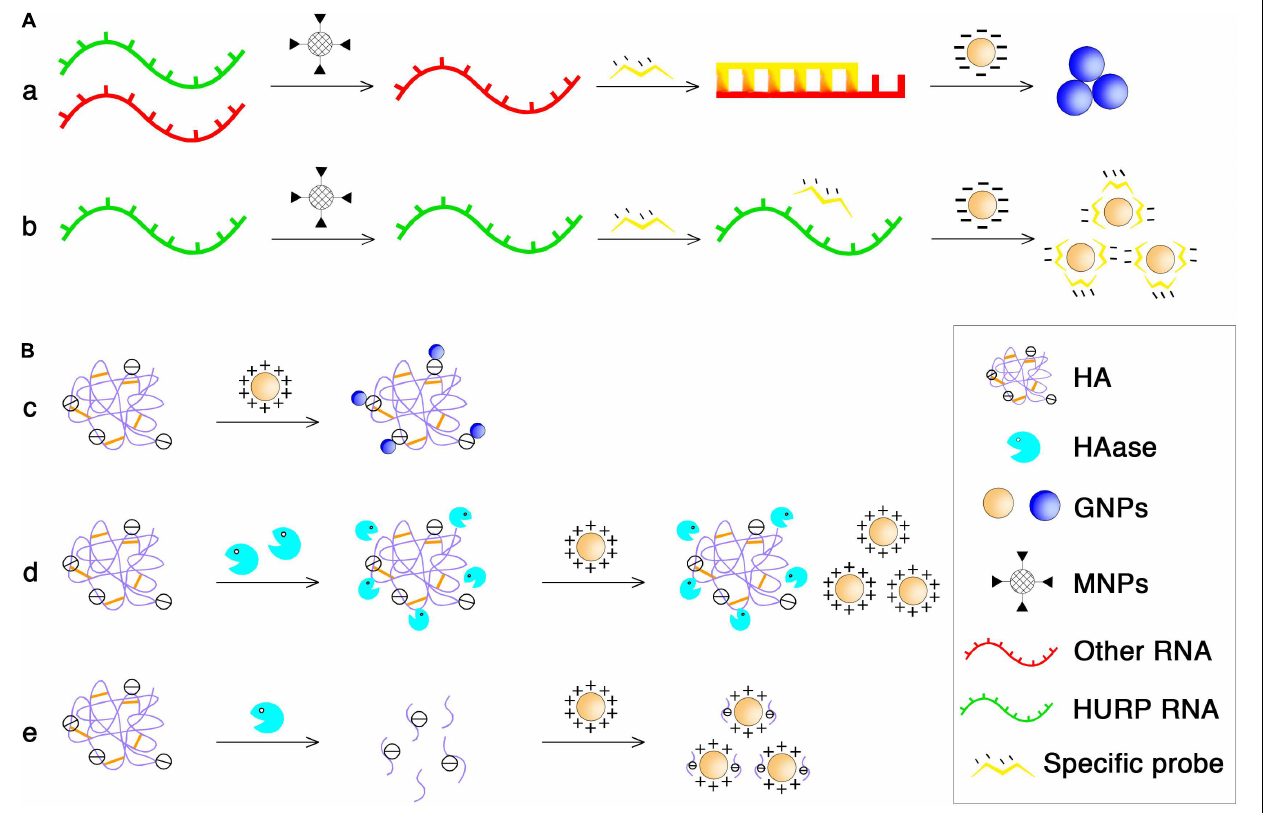
FIGURE 3 | The principle of NP-based diagnosis of BCa. (A) MNPs and GNPs used in purifying total RNA to obtain HURP RNA. (a) MNPs functionalized with oligonucleotide sequences specific for HURP RNA were added followed by mixing with hybridization buffer which contained NaCl, and HURP specific oligonucleotide with purified HURP RNA. After denaturation and annealing, the negatively charged GNPs were added and in the presence of HURP RNA, hybridization occured between the oligotargeter and the HURP RNA, and the solution color shifted from red to blue due to salt-induced aggregation of GNPs. (b) Without HURP RNA, GNPs would not aggregate and the solution color remained red because the oligotargeter remained adsorbed onto the surface of the GNPs. (B) Cationic GNPs directly detected HAase activity. (c) The charge interaction between polyanionic HA and cationic GNPs can lead to the formation of gold aggregates and at the same time a red to blue color shifted. (d) Under conditions of high HAase concentration, the enzyme and HA binds electrostatically even at a 0-min incubation time at 37 ◦ C, no aggregation occurs when the GNP solution is added, and the solution remains red in color. (e) At low concentration conditions, enzymatical reaction at 37 ◦ C for a period of time could lead to the enzyme molecule digest HA into small fragments, resulting in the failure of GNPs